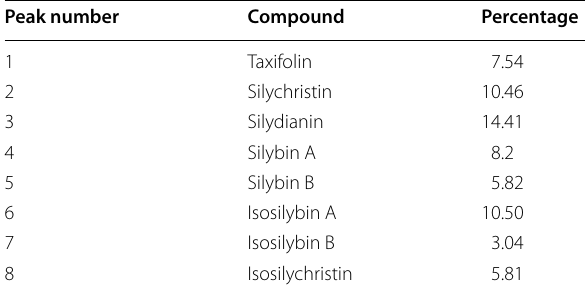
Table 1 Percentage of compounds in ethanolic extract of S. marianum seeds obtained with HPLC analysis Peak number